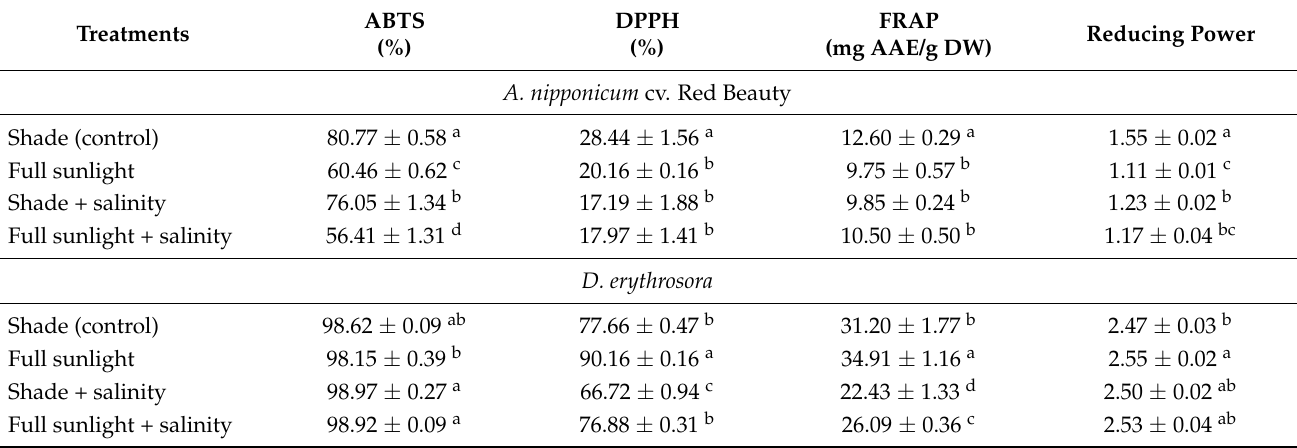
Table 4. Effect of abiotic stresses on antioxidant activity (as measured by ABTS, DPPH, FRAP, and reducing power methods) of two hardy ferns. Within a column means followed by the same lowercase letter are not significantly different at p ≤ 0.05 (ANOVA, Tukey’s HSD post hoc